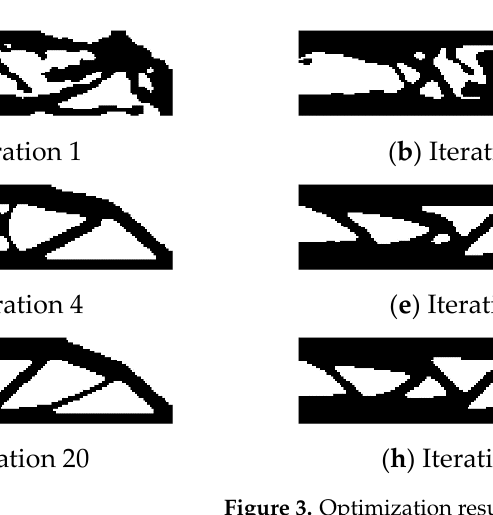
Figure 4. Variation of objective function with iteration steps.